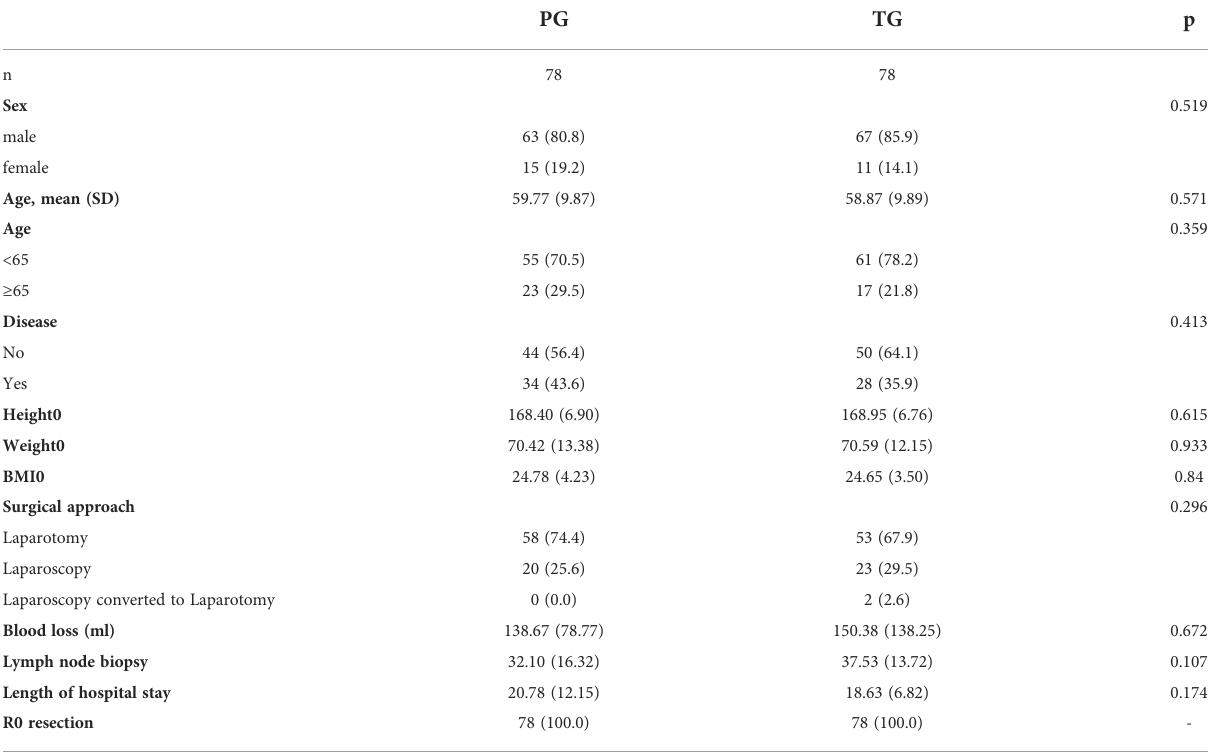
TABLE 1 Demographics and surgical characteristics of patients undergoing PG and TG.